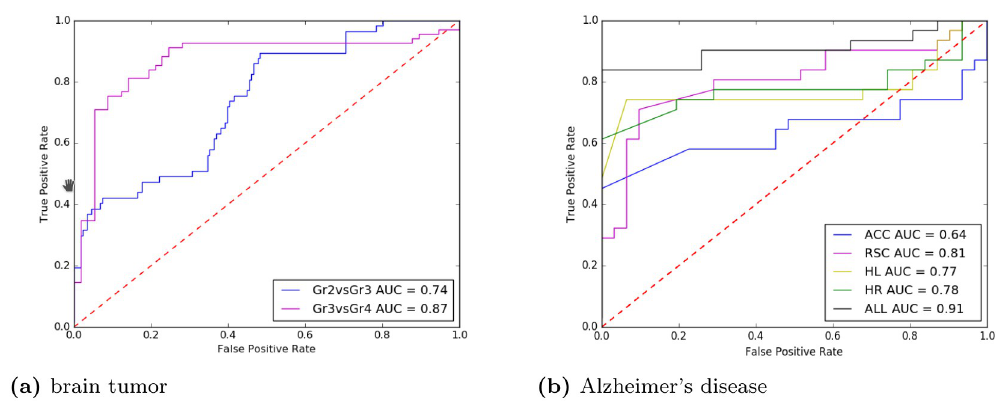
Fig 5. ROC curves corresponding to the best SL-CNN’s classification models. (a) corresponds to the separation of brain glioma tumor grades and (b) to Alzheimer’s disease from normal brain. The highest AUC for the separation of brain tumor grades was achieved for grade 3 versus grade 4. The highest AUC to identify Alzheimer’s disease was achieved for a combination of all 4 investigated areas. AUC is the area under the ROC curve. AUC measures how true positive rate and false positive rate trade off.